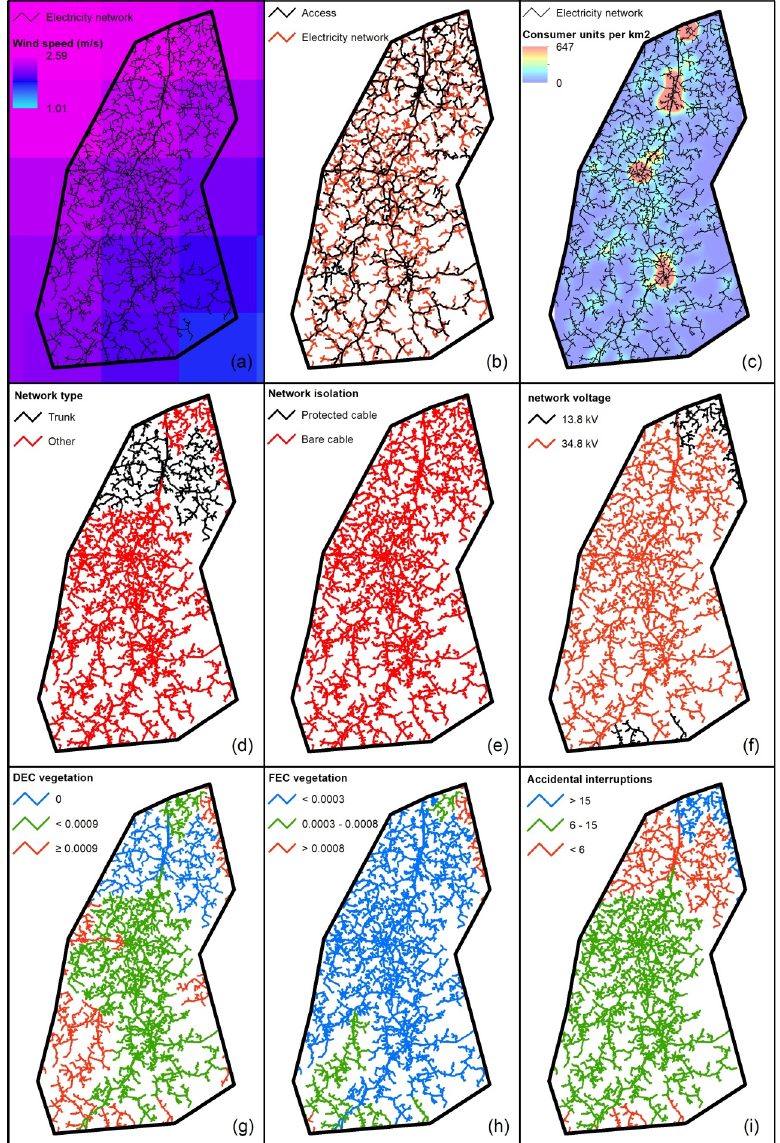
Figure 3. Example of auxiliary data used to compute PIVM for the S3 network. ( a ) Wind speed; ( b ) Access; ( c ) Density of consumer units; ( d ) Network type; ( e ) Network isolation type; ( f ) Network voltage; ( g ) DEC-vegetation, referring to the portion of the total DEC due to the interference of vegetation in the network; ( h ) FEC-vegetation, referring to the portion of the total FEC due to the interference of vegetation in the network; and ( i ) Accidental interruptions shorter than 3 min.